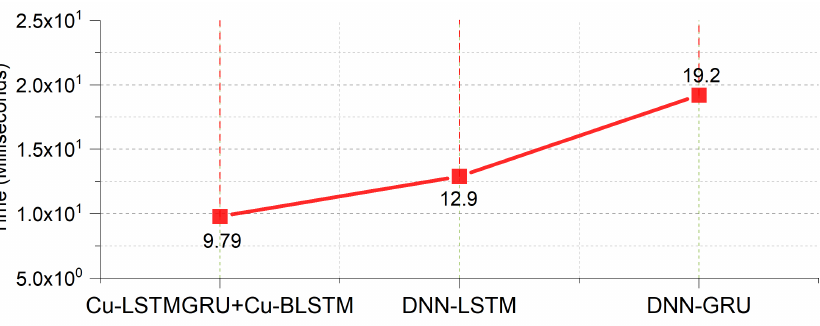
Figure 8. Speed efficiency of the models.